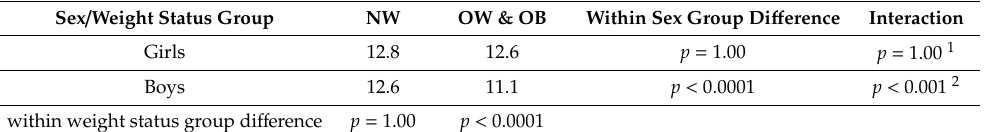
Table 2. Results of 2-way ANOVA representing di ff erences within the sex and weight status group as well as the interaction between groups in total FMS score.